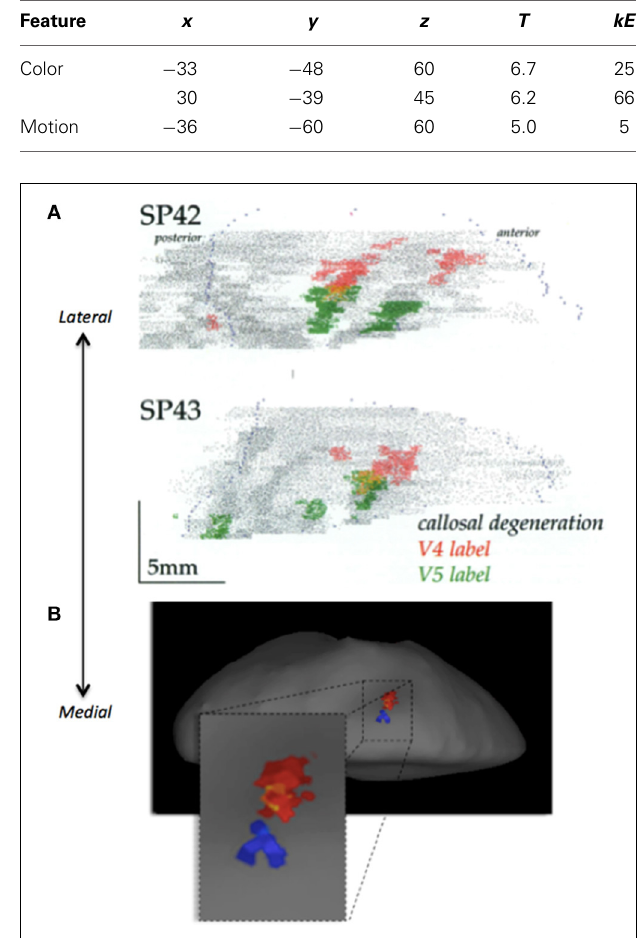
FIGURE 6 | (A) Examples of projections from V4 (red) and V5 (green) to the lateral intraparietal sulcus (LIP) in two different monkeys (SP42 and SP43; Reproduced with permission from Shipp and Zeki, 1995). (B) Illustration of juxtaposed activity relating to color (red) and motion (blue) concepts. The data is taken from the average of all 16 subjects and superimposed onto the inflated group average structural. Projections from V5 in monkey, and motion related activity in humans, both appear to be more medial, relative to V4 projections in monkey and color activity in humans, appearing more